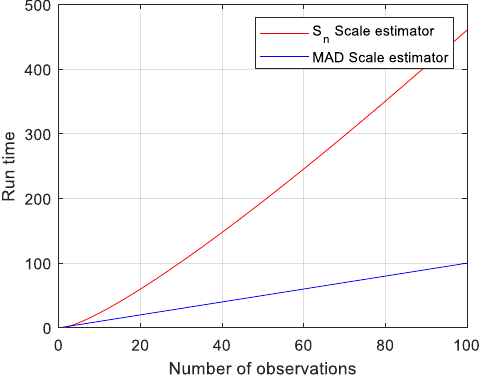
Figure 15. Computational time comparison.